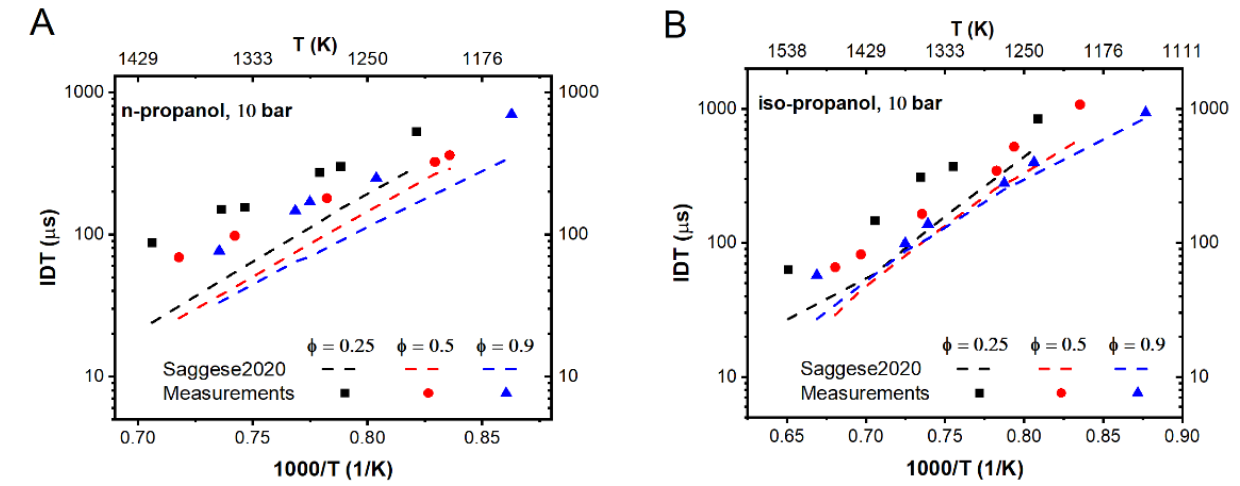
Figure 3. IDTs of ( A ) n-propanol, and ( B ) iso-propanol measured in the HPST at 10 bar and ϕ = 0.25, 0.5, and 0.9.